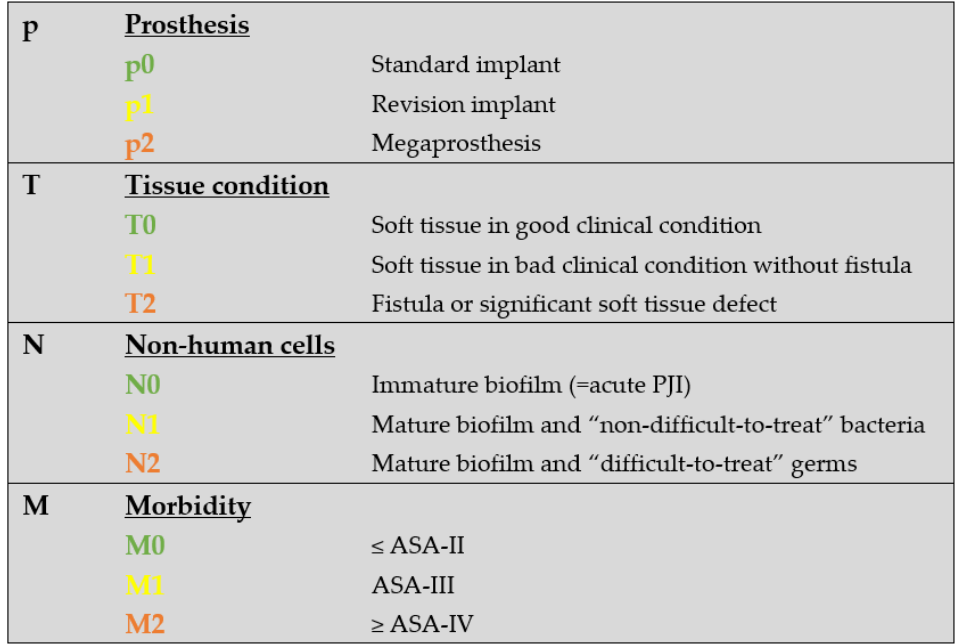
Figure 3. The modified PJI-pTNM classification. Type of infected prosthesis “p-status” is added to the TNM-backbone, making it “pTNM”. An “x” in front of the p-status indicates if a loosened implant is assumed or confirmed. Morbidity is assessed based on the ASA classification. The number behind each letter indicates uniformly the degree of severity on a scale from 0 to 2, with 2 being most severe. If the current PJI involves a previously infected joint, the situation is considered as “reinfection” and an “r” is put in front of pTNM.